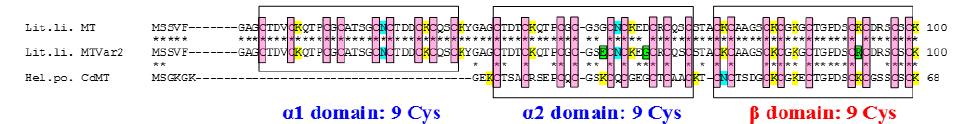
Figure 1. Alignment of Littorina littorea Metallothionein (MT) (Lit.li. MT, GenBank Acc. No. AAK56498), with its allelic variant (Lit.li. Var2, GenBank Acc. No. KY963497), and with the paradigmatic Cd-specific MT isoform of the terrestrial snail, Helix pomatia (Hel.po. CdMT, GenBank Acc. No. AAK84863.1). Throughout, conserved cysteine (Cys) positions in the peptide chains are highlighted by a pink box. In the sequence of the allelic Lit.li. MTVar2, the amino acid positions exchanged with respect to the wildtype Lit.li. MT sequences are shown in green . Also highlighted in yellow are the Lysine (K) residues whose preponderance over Aspargine (N) (highlighted in blue ) in the sequences is supposed to confer to the respective peptides a high Cd(II) binding preference [19]. The transparent boxes indicate the supposed three-domain structure of the three MT proteins, which has been experimentally verified by solving the structure of Littorina littorea MT [20]. According to this, the Helix pomatia CdMT consists of two modular domains (one α 2 and one β domain), whereas the two MT variants of Littorina littorea comprise three modular domains (two α domains, i.e., α 1 and α 2, and one β domain). In each of the above-shown proteins, every domain includes 9 Cys residues that provide 9 sulfur atoms for the binding of 3 divalent metal ions (such as Cd(II)). Identical positions between adjacent sequences are indicated by stars. The number of residues in the respective peptide chains is specified near their C-terminal end.